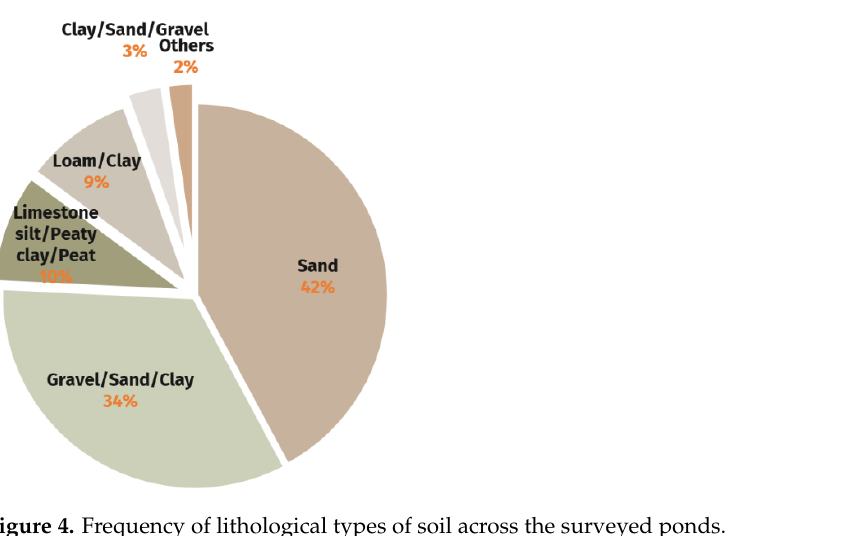
Figure 4. Frequency of lithological types of soil across the surveyed ponds.